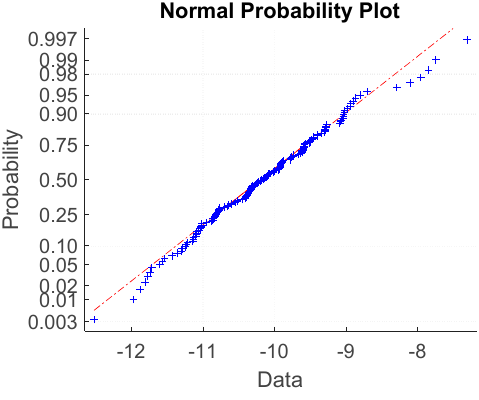
Figure 27. Synthetic data reproduction of field-scale wellbore hydrologic recharge distribution, for the Borrowdale Volcanics Group (BVG) metamorphic rock suite at the Sellafield nuclear facility [25]. Energies 2017 , 10 , 1979